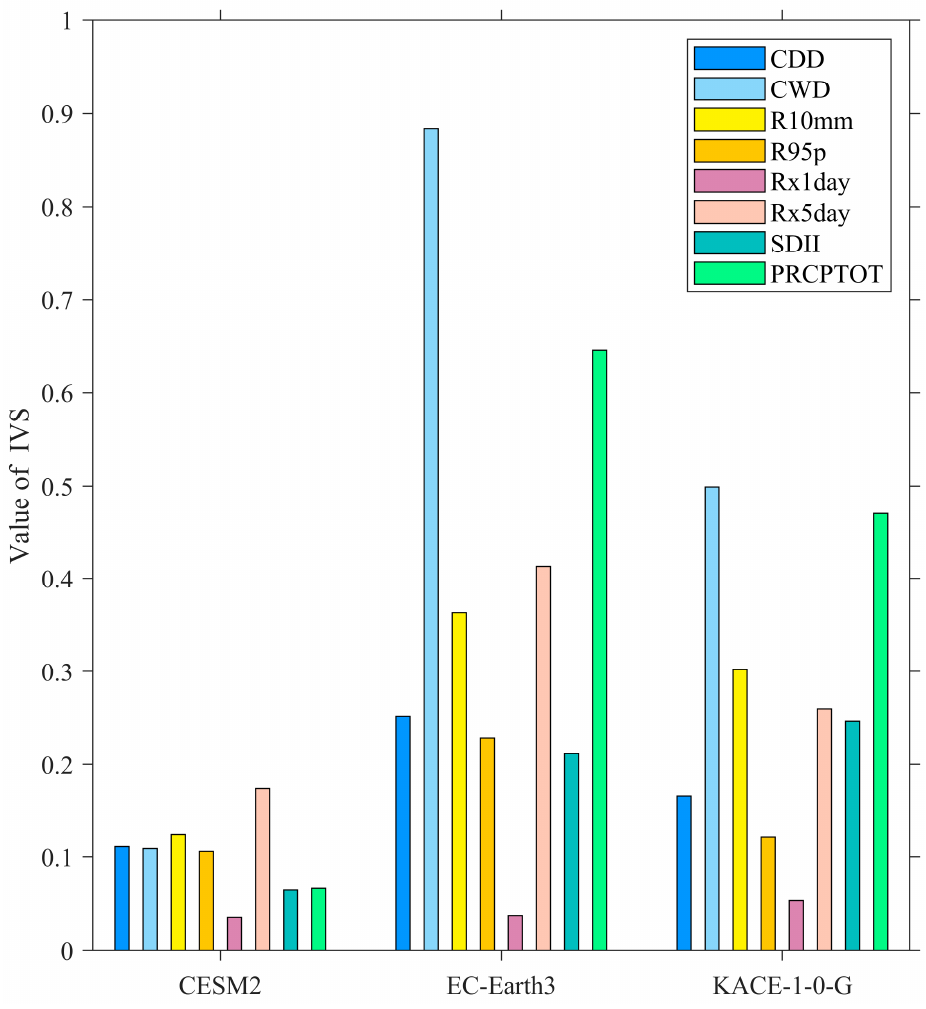
Figure 6. The IVS scores of the corrected CMIP6 models for eight extreme precipitation indices over the Qilian Mountains.